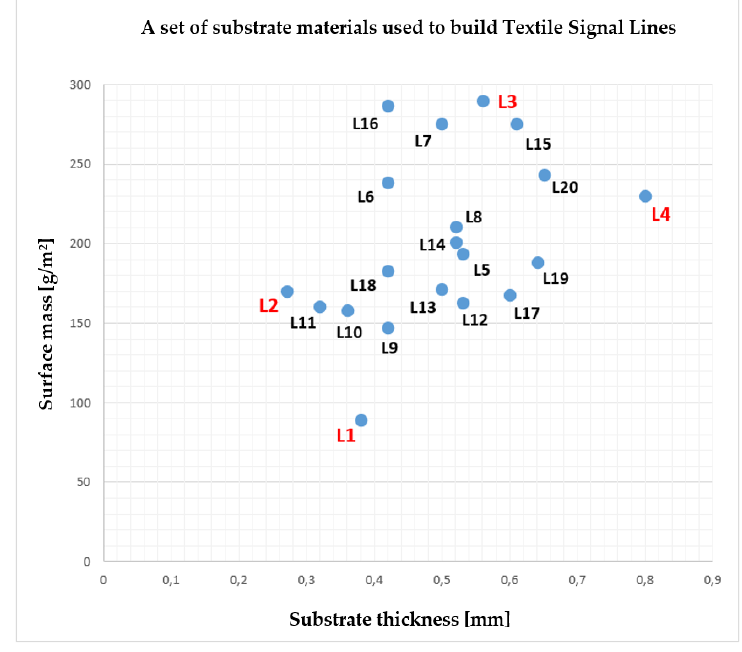
Figure 3. Chart with twenty sewed textile signal lines with their substrate properties.